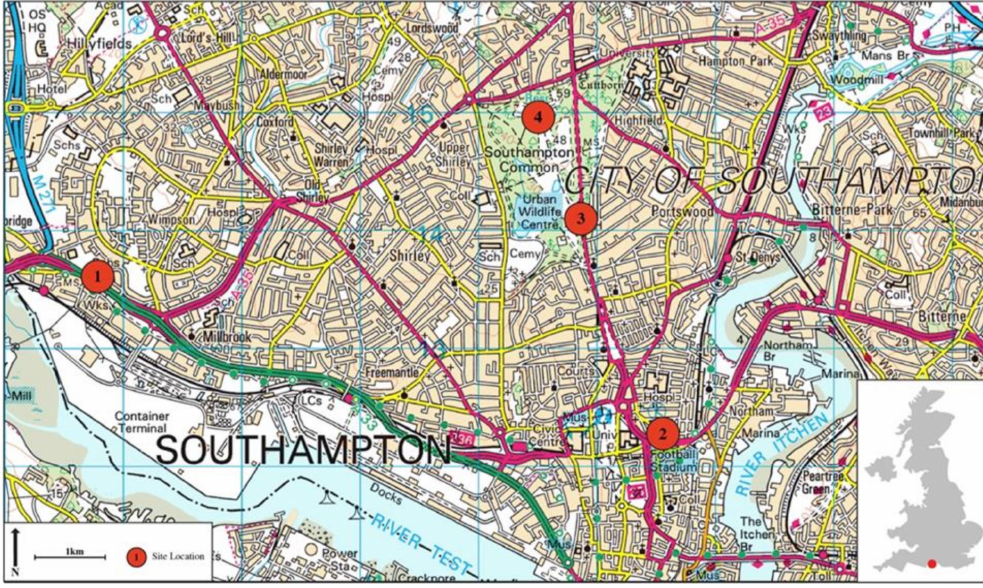
Figure 1. Sample site location map of Southampton. Site 1: Redbridge road; Site 2: Brinton’s Road; Site 3: The Avenue; Site 4: Southampton Common. (Red lines are major (A) roads) Adopted from Edina Digimap